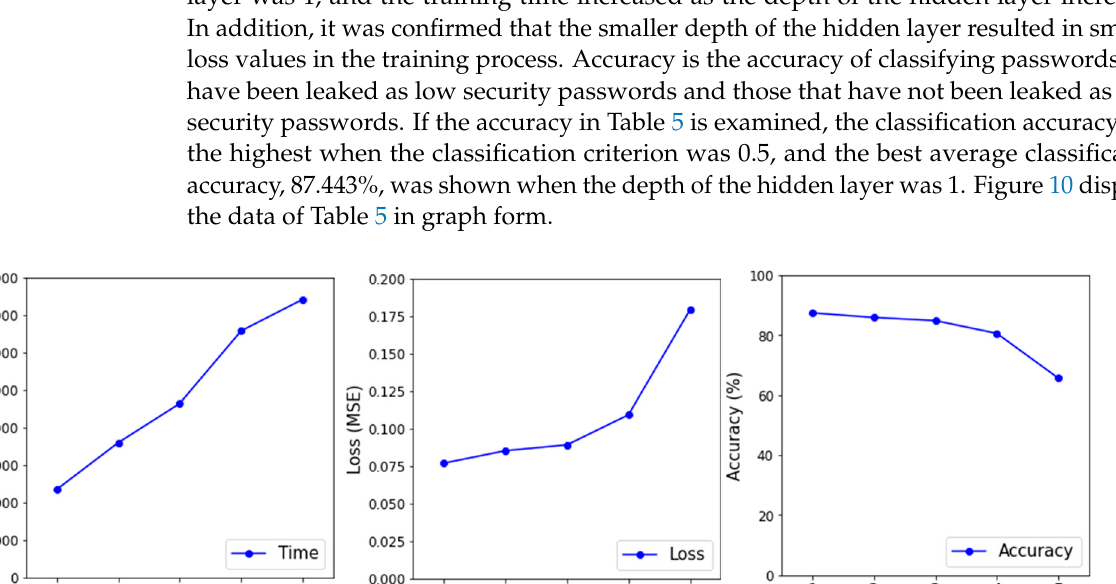
Table 6. Performance table of the evaluation model according to the number of nodes. Number of